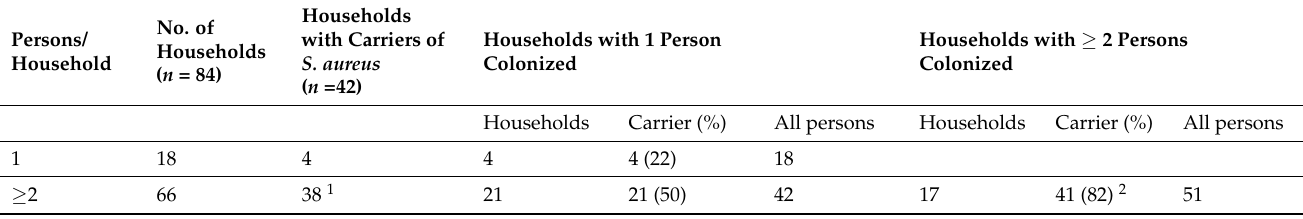
Table 2. Households, number of persons, and S. aureus colonization of